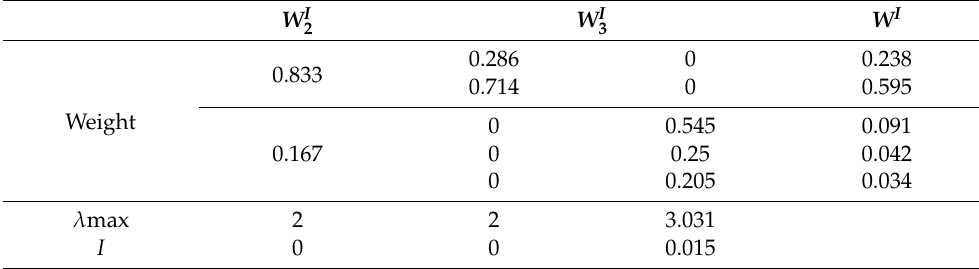
Table 9. Weight calculation results of the